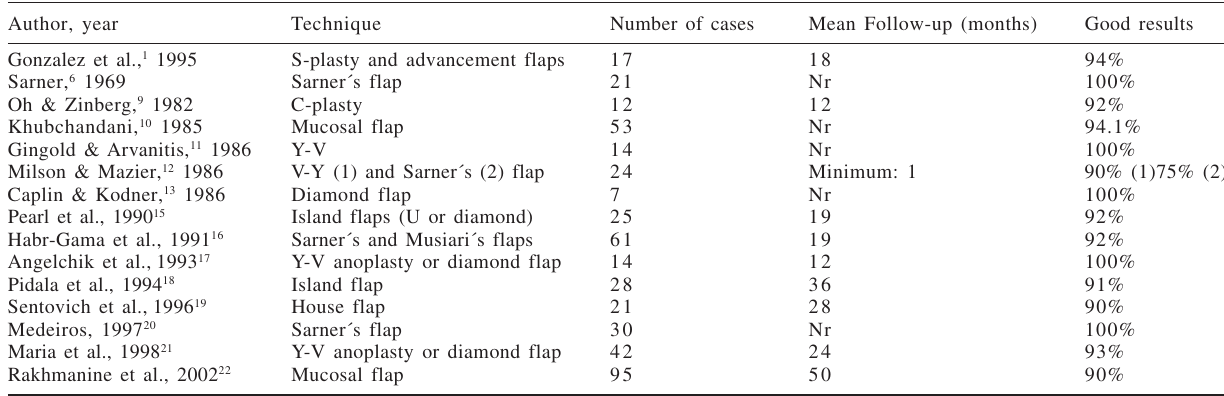
Table 3 - Summary of literature review of anoplasty operations for anal